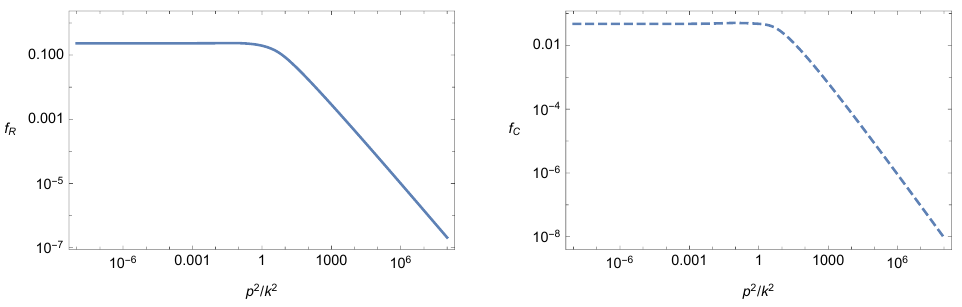
Figure 6. Fluctuation form factors reconstructed from the dynamical anomalous dimensions accord- ing to (51) for the choices g = 1, µ TL = 0, µ 0 = 0, β h = 1 and the regulator (83). The dashing indicates that the function is negative. For clarity, we have reinstated k in the momentum argument.